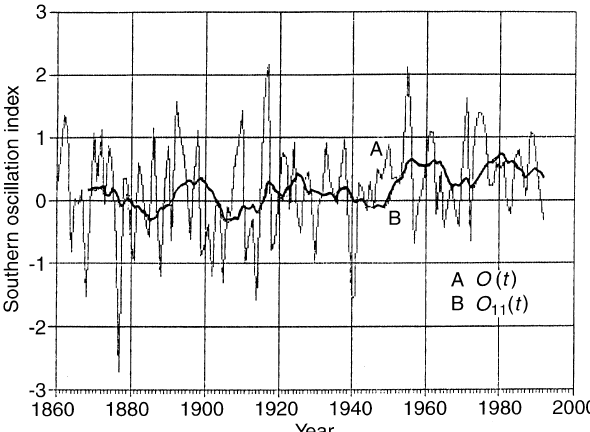
Fig. 1. Southern Oscillation (annual and long-term)